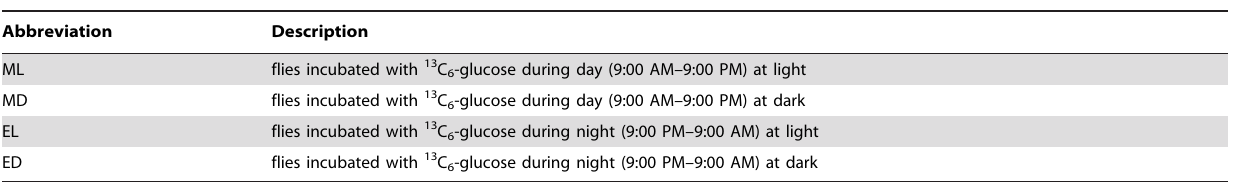
Table 1. Notation used in this